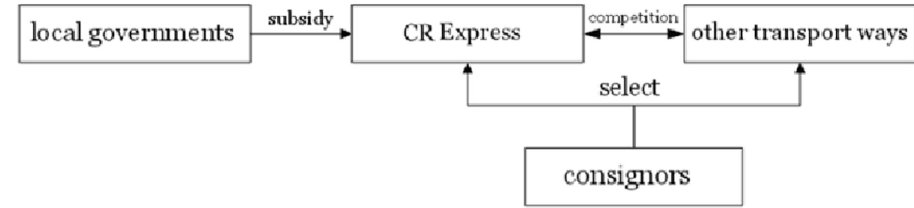
Fig 1. Relationships between market